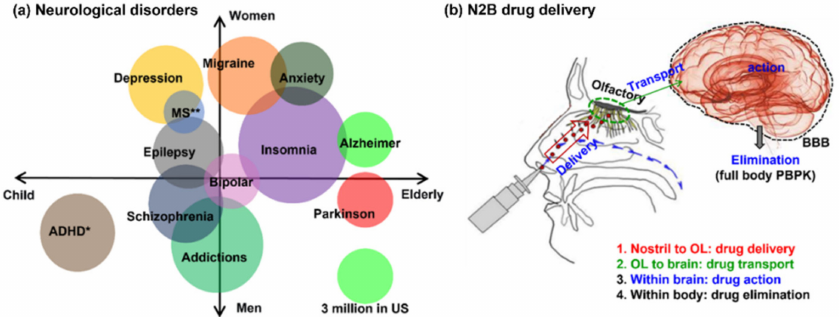
Figure 1. Prevalence and treatment of neurological disorders (NDs): ( a ) various types of NDs and their prevalence (scale: the green circle representing 3 million patients), and ( b ) four stages of nose-to-brain (N2B) drug delivery: (1) intranasal drug delivery to the olfactory mucosa, (2) drug transport from the olfactory mucosa to the brain (tissue transport), (3) drug action in the brain (pharmacodynamics), and (4) drug elimination from the brain and